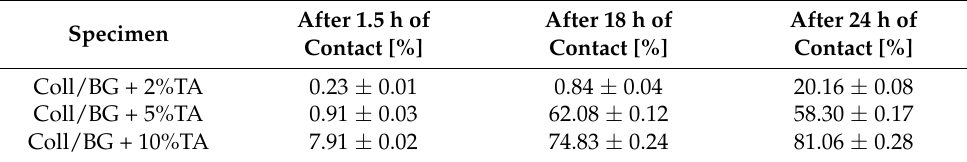
Table 1. The antioxidant properties of the hydrogels during different incubation times.